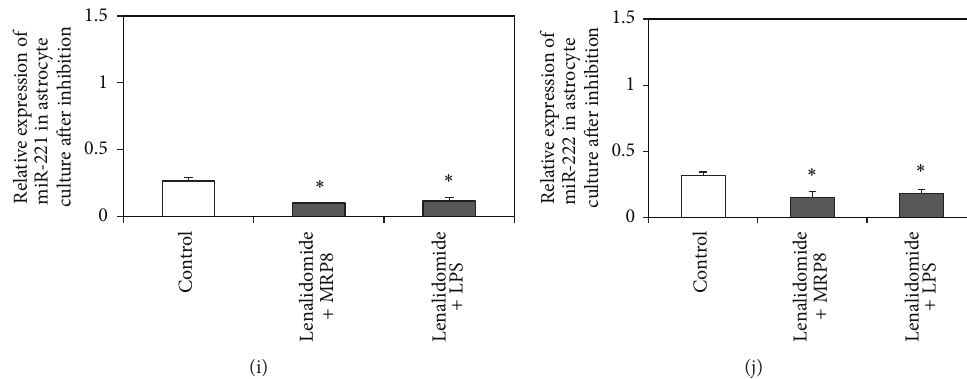
Figure 3: ((a), (b), (c), (d), (f), (g), (h), (i), (j)) qPCR results showed significant downregulation of miRNAs (124, 134, 9, 132, 146a, 21, 181a, 221, and 222) after inhibition with lenalidomide compared to stimulated astrocytes, while miRNA-138 was significantly upregulated after inhibition with lenalidomide compared to stimulated astrocytes